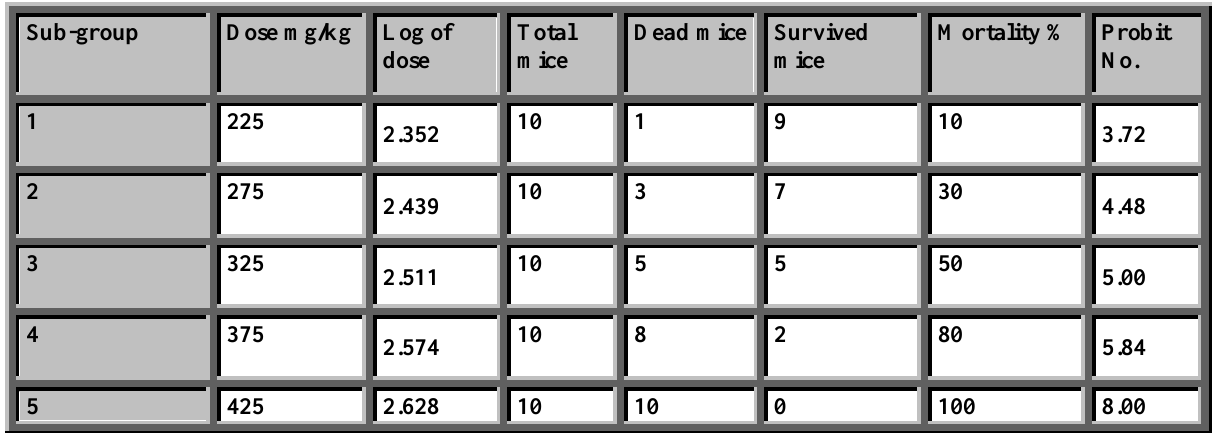
Table 2:- Acute toxicity effect of different doses of hexane extract of RFG of N.oleander leaves in